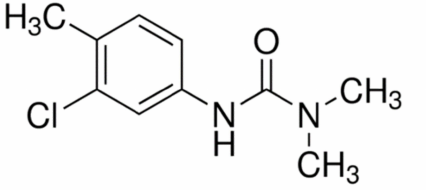
Figure 1. Molecular structure of chlortoluron